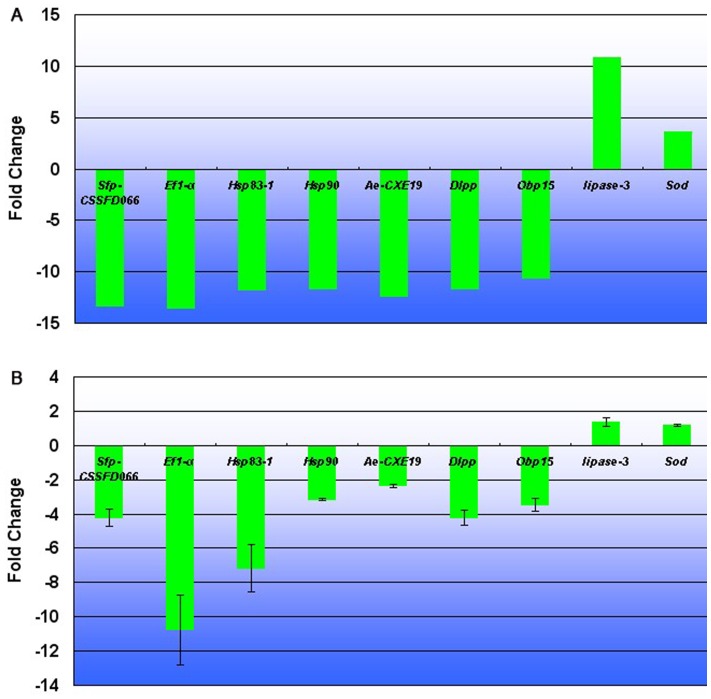
Verification of differentially expressed genes (DEG) by qRT-PCR.(A) DEG data in transcriptome analysis. The fold changes of the genes were calculated as the log2 value of each AD_1/CY_1 comparison and are shown on the y-axis. (B) The qRT-PCR analysis of gene expression data. Expression ratios of selected genes in AD-1 compared to CY_1.